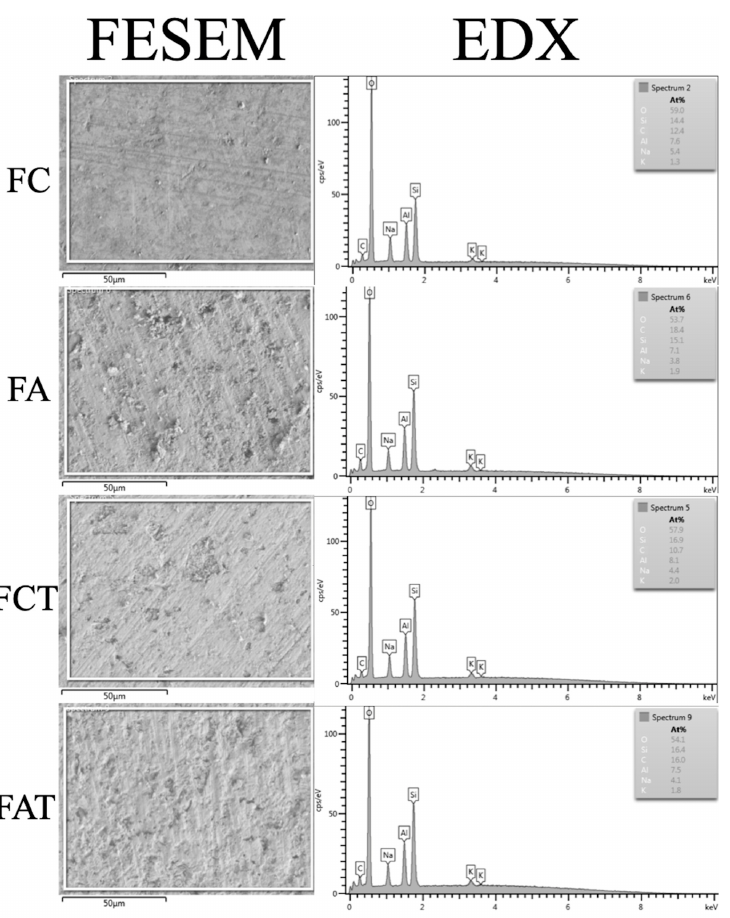
Figure 3. Field emission scanning electron microscope (FESEM) images and energy dispersive X-ray spectroscopy (EDX) analysis of material groups (C: carbon; O: oxygen; Na: sodium; Al: aluminum; Si: silicon; K: potassium).